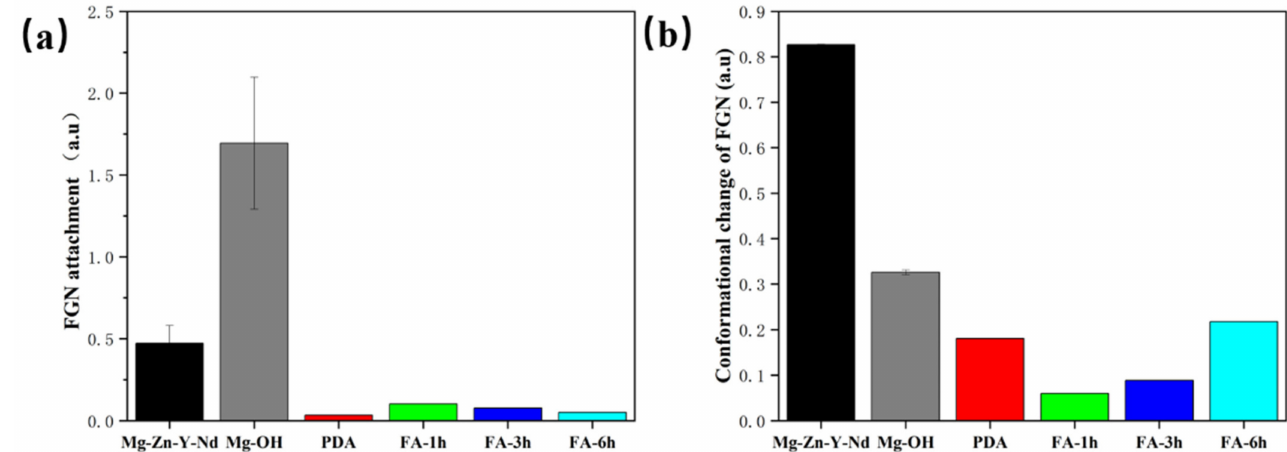
Figure 10. Adhesion ( a ) and denaturation ( b ) of FGN in each sample (mean ± SD, n = 3). Research shows that Mg alloys have poor blood compatibility due to rapid degrada- tion [43]. As shown in Figure 11, consistent with the literature, the Mg alloy was corroded, and a large number of platelets gathered on the surface, indicating that the Mg alloy may induce platelet activation. On the PDA coating, the platelets were partially aggregated, interconnected, and they extended pseudopodia showing a flat shape and a fully activated state, which indicated that the anti-platelet aggregation ability of PDA coating was poor. This may be because the PDA coating has good hydrophilicity and contains a large number of positive charges, which will adsorb negatively charged platelets and fibrin. After